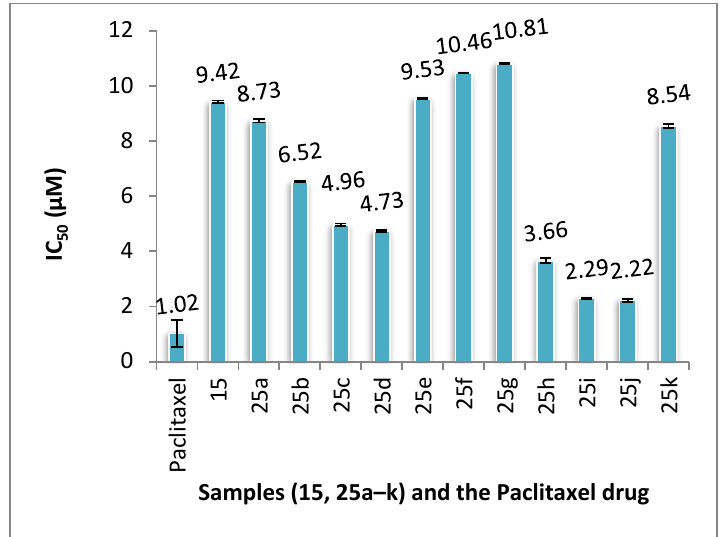
Figure 1. Effect of compounds ( 15 , 25a – k ) on the proliferation of MCF-7 breast cancer cells using 3-(4,5-dimethylthiazol-2yl)-2,5-diphenyl tetrazolium bromide (MTT) cell viability assay. The IC 50 of the tested compounds was calculated after 24 h.